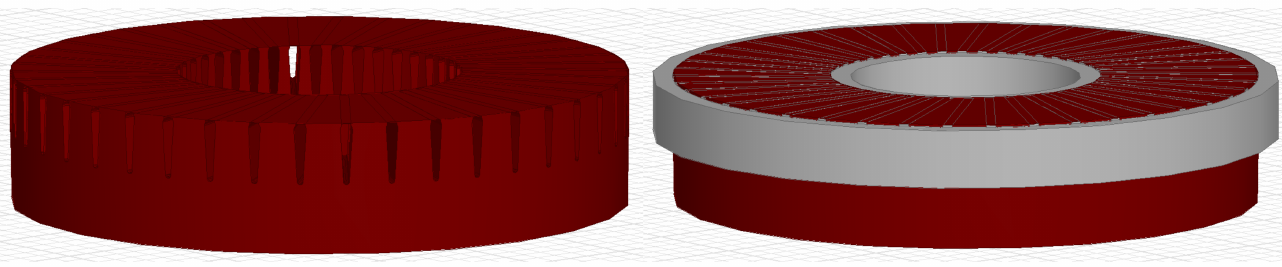
Figure 7. The 3D geometry of the symmetrical half of an inner rotor package with optimized, tilted, and closed slots ( left ); the same model after inserting the squirrel cage ( right